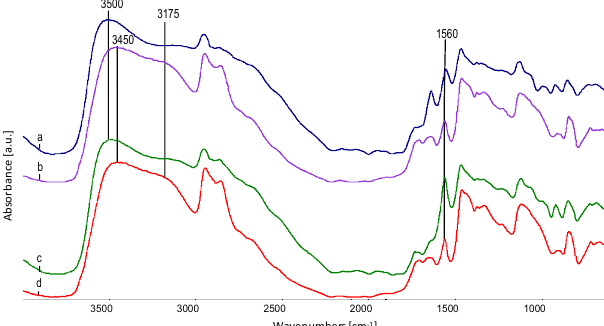
Figure 10. Combination of fibre spectra before and after extraction in water: ( a ) A series not extracted; ( b ) A series extracted; ( c ) B series not extracted; ( d ) B series extracted.